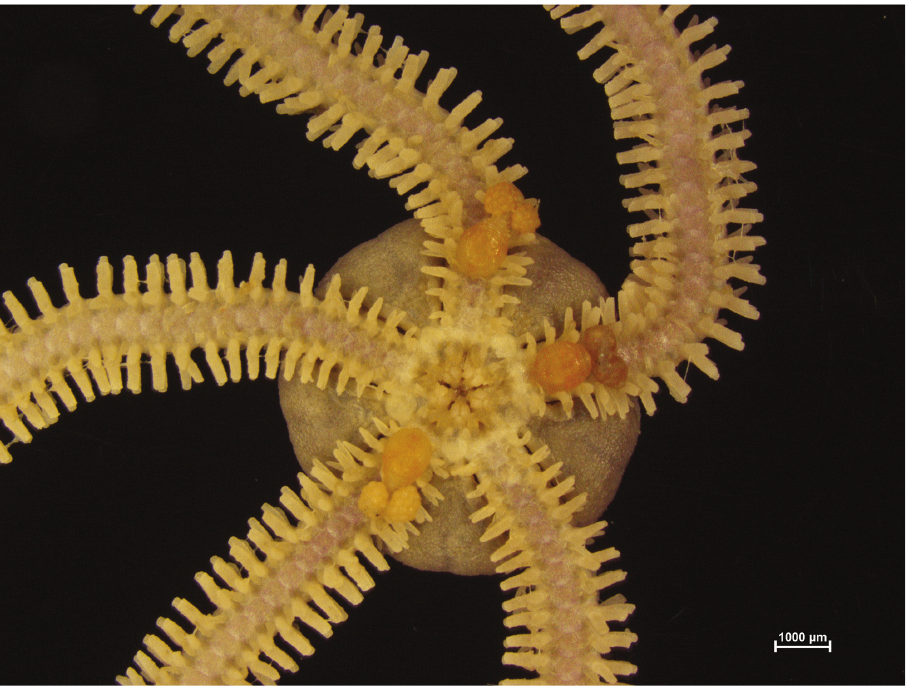
Figure 1. Amphiura capensis , showing three ovigerous female Cancerilla oblonga atached to ventral surfaces of arms.